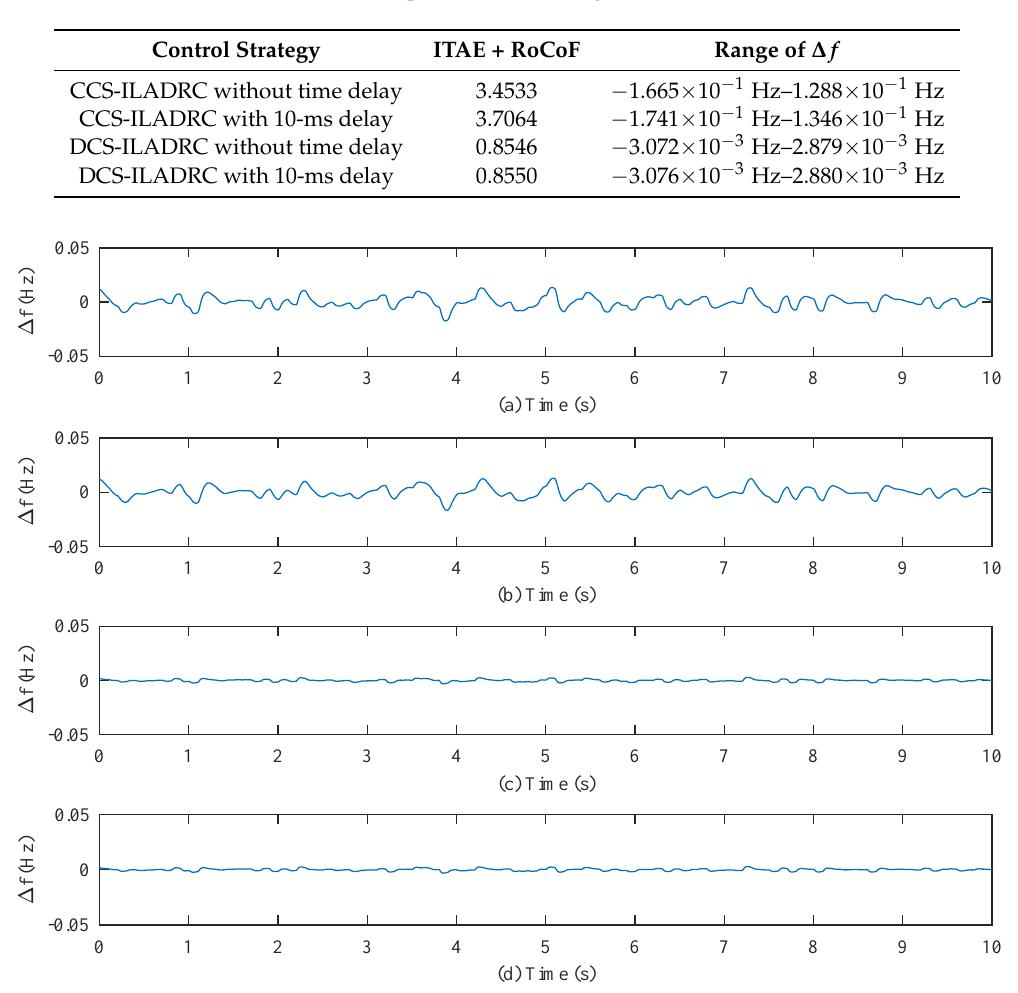
Table 6. Performance comparison considering the stochastic disturbance.